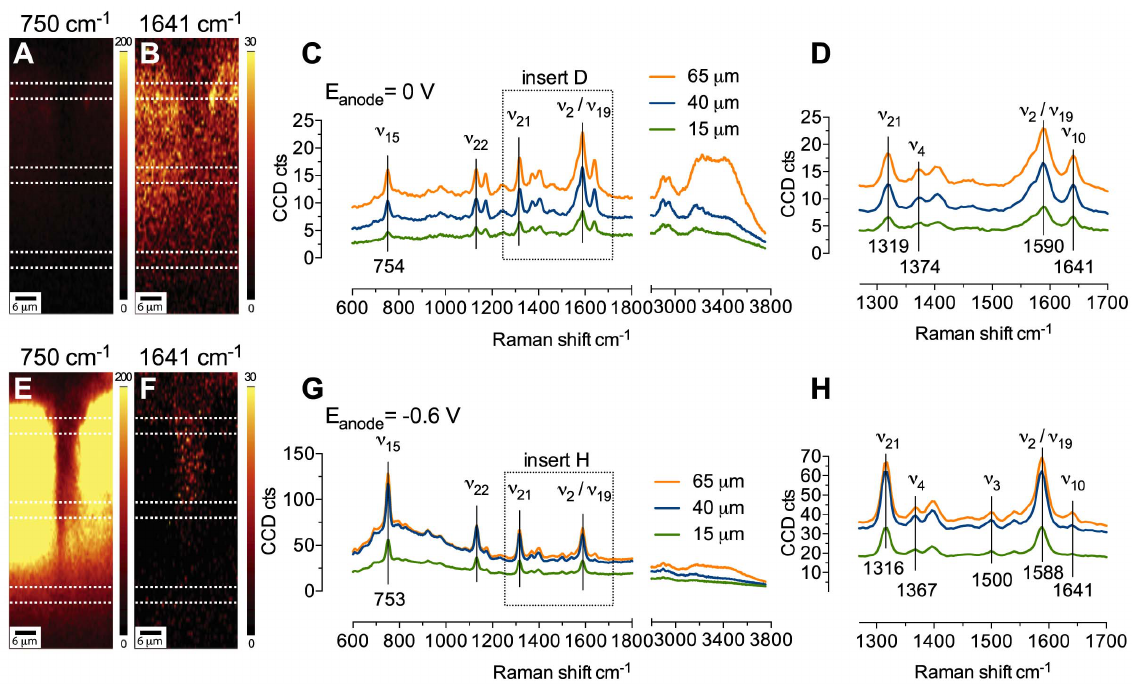
Figure 3. Biofilm sectional images and average RR spectra collected from electroactive biofilm at day 57 since inoculation under nonturnover conditions, with the electrode poised at 0 V (A, B, C, and D) or at 2 0.6 V (E, F, G, and H). Sectional maps (A, B, E, and F) are generated by binning the whole spectral information at 750 cm 2 1 (A and E), and at 1641 cm 2 1 (B and F), used here as markers of reduced and oxidized cytochromes, respectively. Each spectrum was averaged within the areas indicated by the dotted lines, representative of three biofilm locations, that is, top, middle, and bottom, respectively at a distance of 65, 40, and 15 m m from the electrode surface (not visible at the bottom of the spectral maps). The biofilm was exposed to the respective potentials for a period of at least 20 minutes to allow complete oxidation or reduction of cyt c , as suggested by stabilization of the current profile to very low levels (profiles shown in Figure S2A and B).